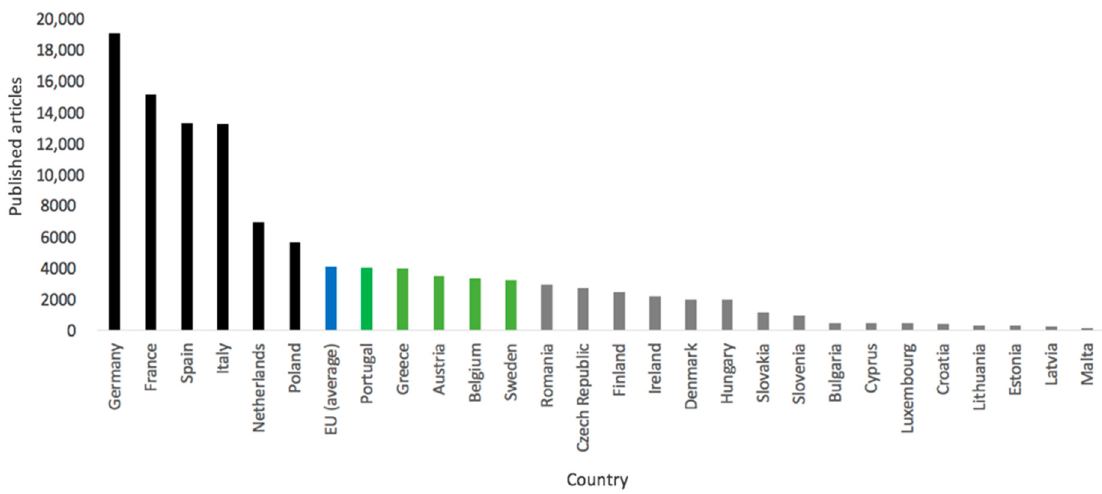
Figure 1. European Union´s research potential (adapted from Reis et al. 2020b).